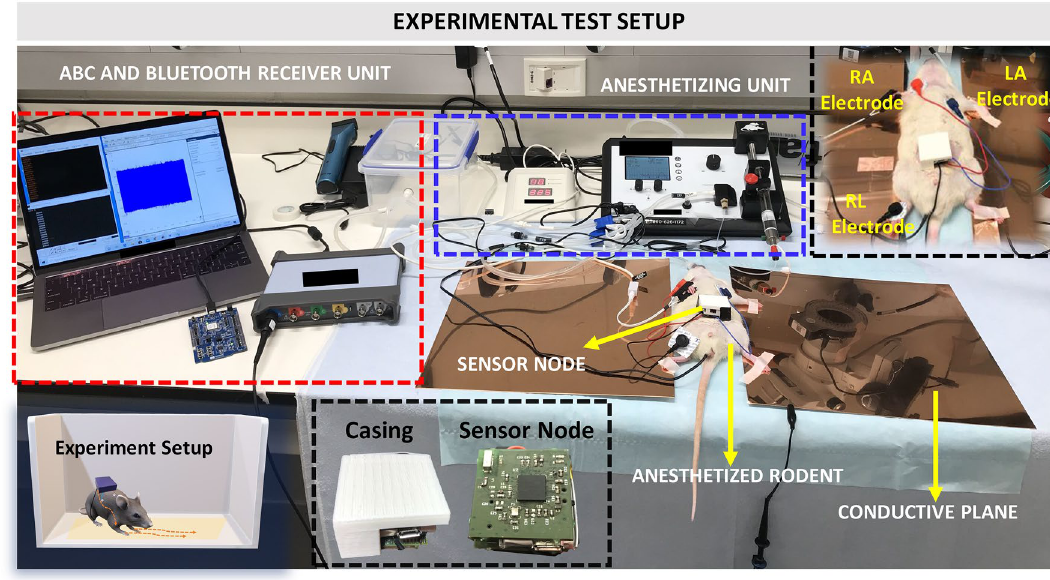
Figure 4. Experimental Test Setup: The sensor node is placed on the rat skin surface and connected to the surface electrodes (Right Arm (RA), Left Arm (LA), and Right Leg (RL)) for EKG sensing. The rat’s feet are taped on a conductive copper plate, the plate is then connected to a receiver for ABC transmission. The Bluetooth receiver and the ABC receiver are connected to the computer for signal acquisition and